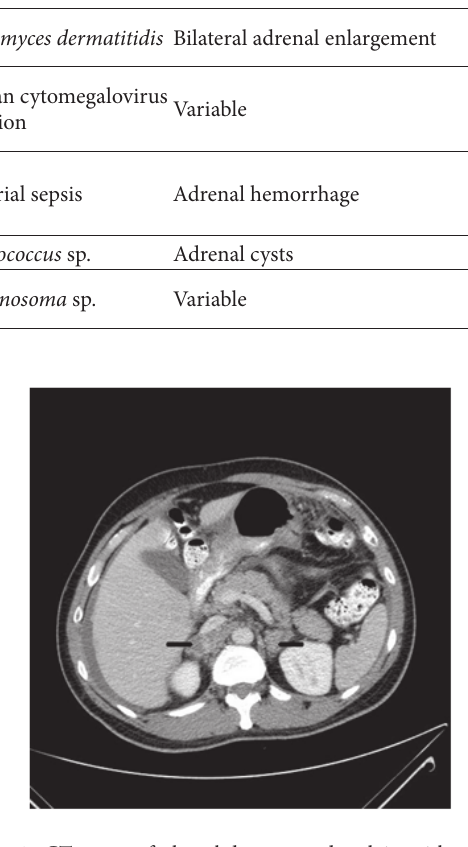
Figure 1: CT scan of the abdomen and pelvis with oral and intravenous contrast showing bilateral adrenal enlargement (black